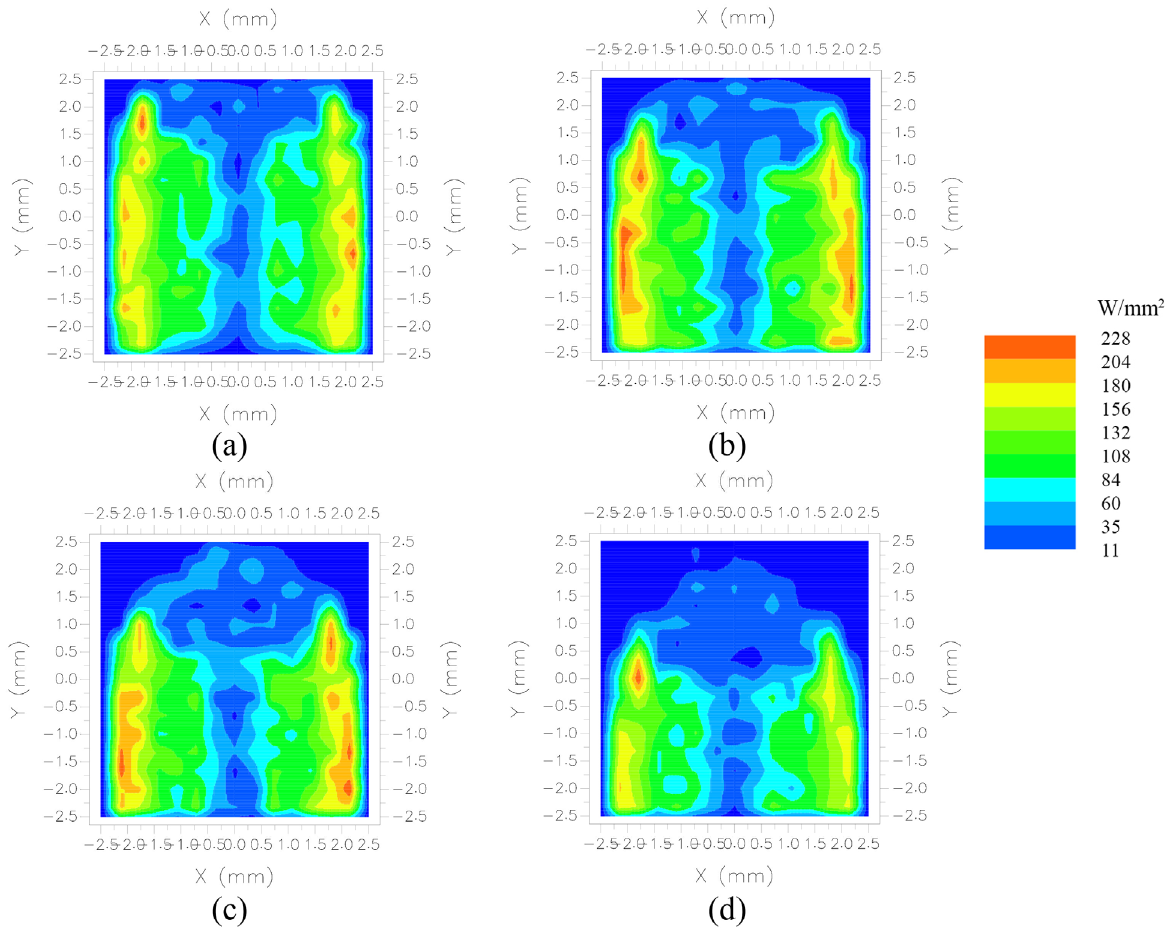
Figure 11. Irradiance profile for incident angles: ( a ) 0.1°, ( b ) 0.2°, ( c ) 0.3°, and ( d ) 0.4°.